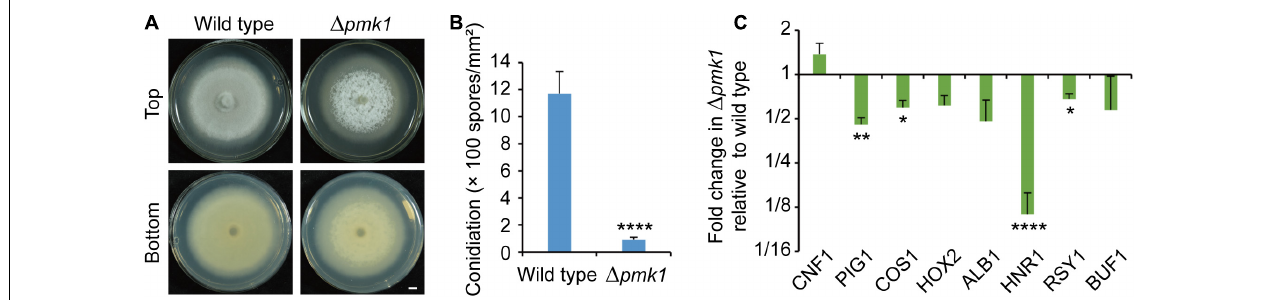
FIGURE 7 | Pmk1 is required for regulation of melanin synthesis and conidiation. (A) Images of colonial morphology and color of the wild-type 70-15 and its derived mutant (cid:49) pmk1 70 - 15 . Bar = 5 mm. (B) Conidiation in the wild-type 70-15 and its derived mutant (cid:49) pmk1 70 - 15 . (C) Relative expression levels of two genes involved in conidiation ( COS1 and HOX2 ) and six melanin synthesis-related genes ( CNF1 , PIG1 , HNR1 , ALB1 , RSY1 , and BUF1 ) in aerial mycelia of (cid:49) pmk1 70 - 15 . The data were shown after comparison with the wild-type 70–15. β -TUBULIN and H3 were used as reference genes. (B,C) Error bars represent ± SD. Significant differences between the wild-type 70-15 and (cid:49) pmk1 70 - 15 were estimated by Tukey’s HSD test (* p < 0.05, ** p < 0.01, and **** p < 0.0001).